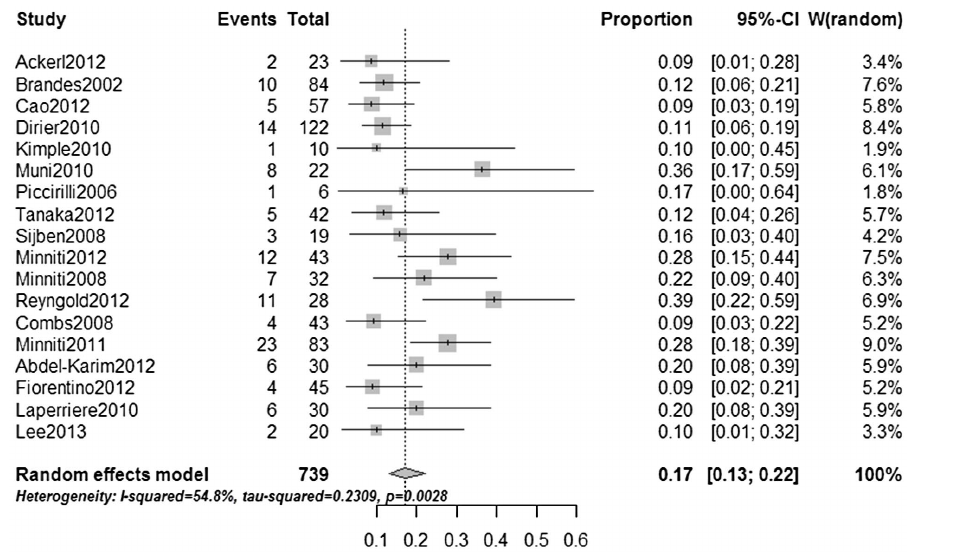
Figure 3. The aggregate estimate for the incidence of patients who experienced at least one grade 3–4 hematological adverse event in combined RT/TMZ groups.